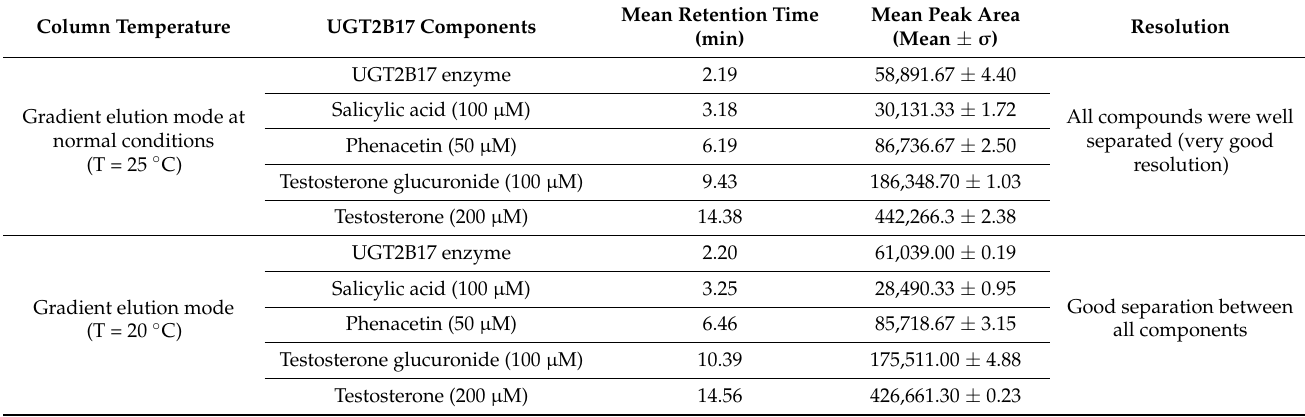
Table 5. Effect of column temperature on retention time and peak area of UGT2B17